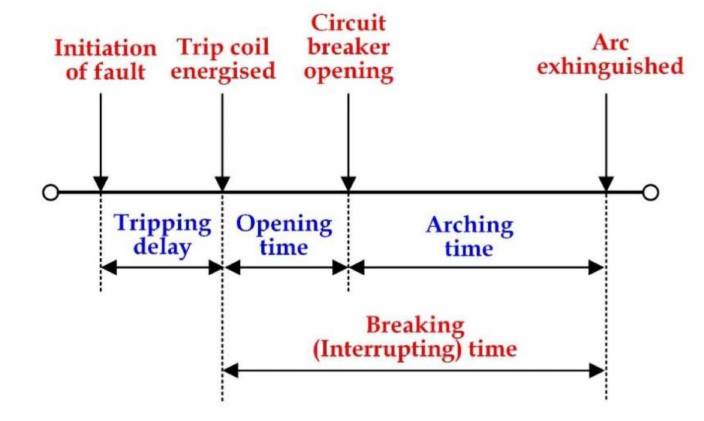
Figure 2. Phases of total clearing time in the circuit